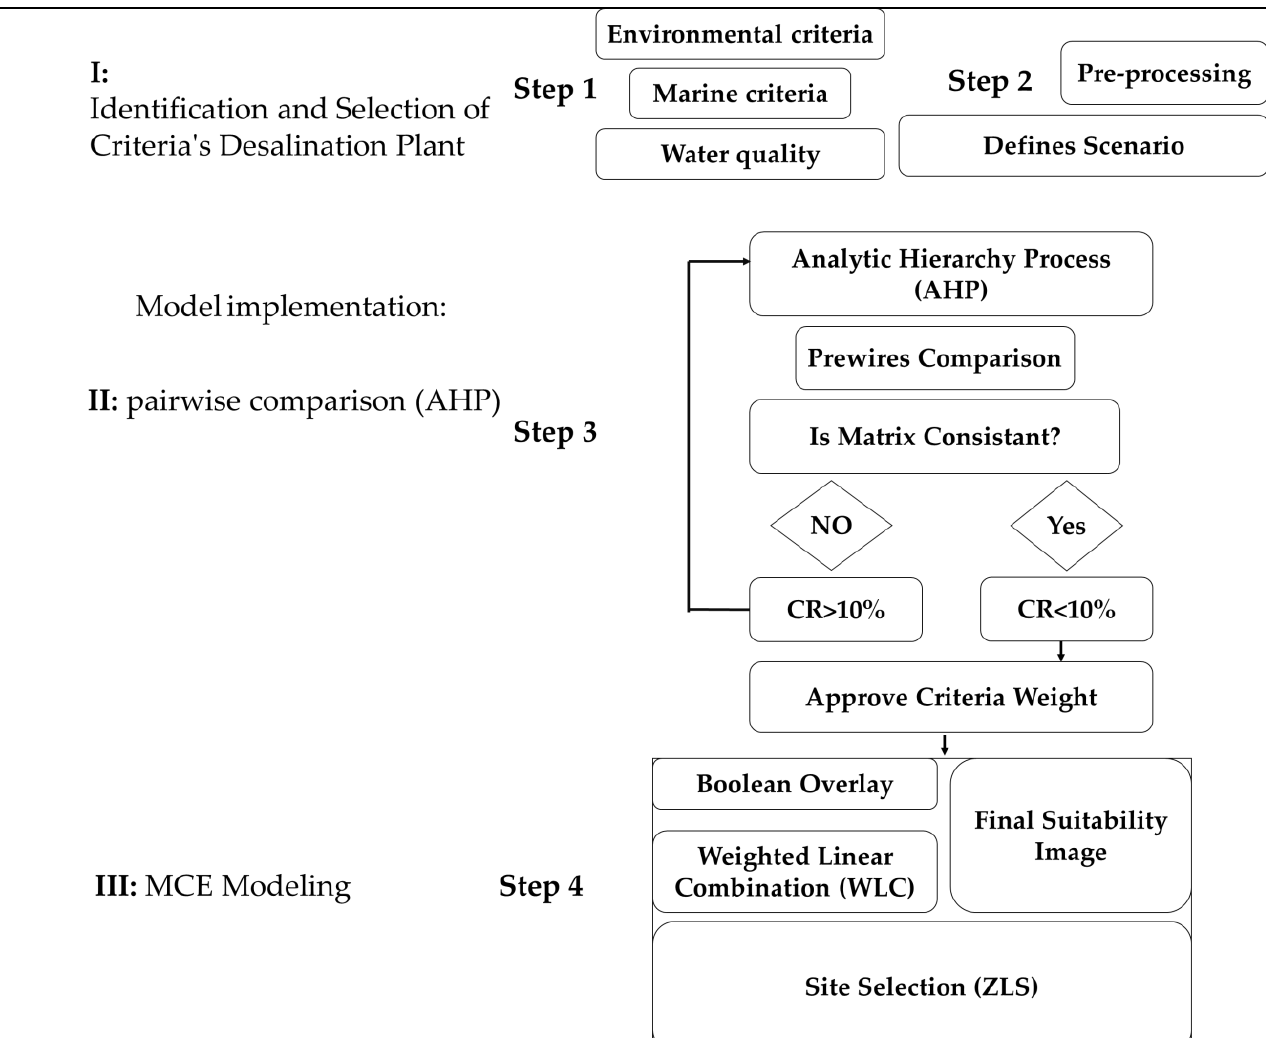
Figure 2. The proposed problem-solving procedure is depicted in the flowchart.